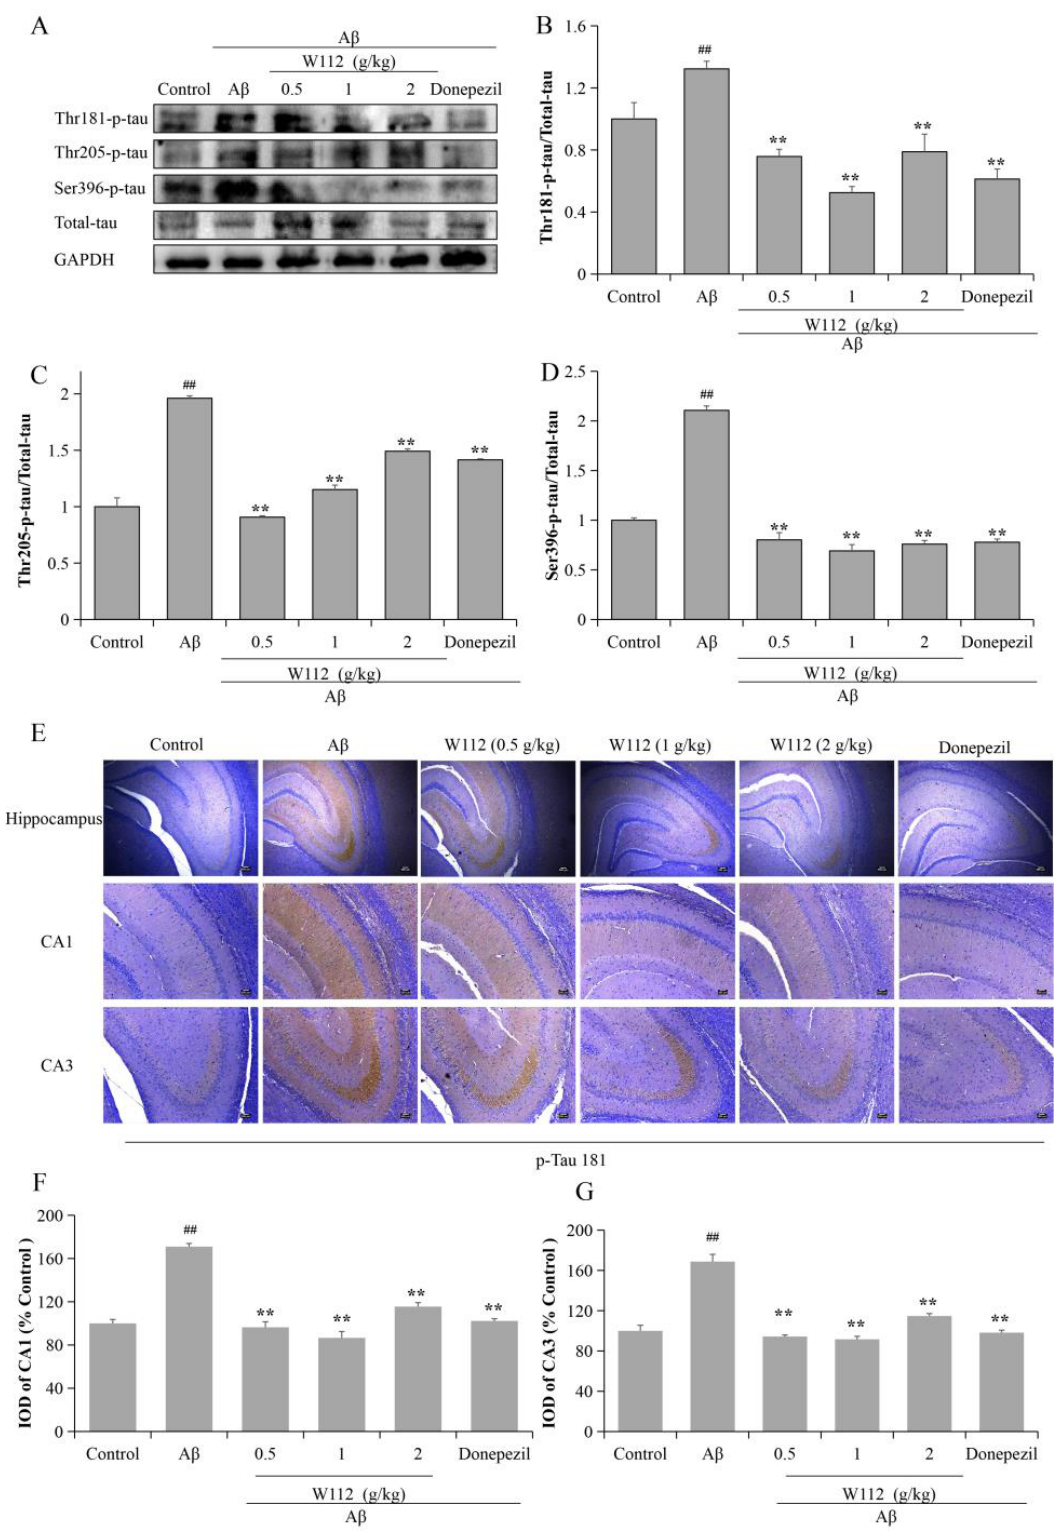
Figure 4. W112 prevented tau pathology in A β 25–35 -induced rat model. ( A – D ) The protein levels of phosphorylated tau at thr181, thr205, and Ser396 sites in the hippocampus of rat model were measured by Western blot. n = 8. ( E – G ) IHC staining of rat brain immunostained with antibodies against thr181-phosphorylated tau (scale bar, Hippocampus: 500 µ m; CA1, CA3 region: 250 µ m). n = 4. ## p < 0.01 vs. the control group; ** p < 0.01 vs. the model group.